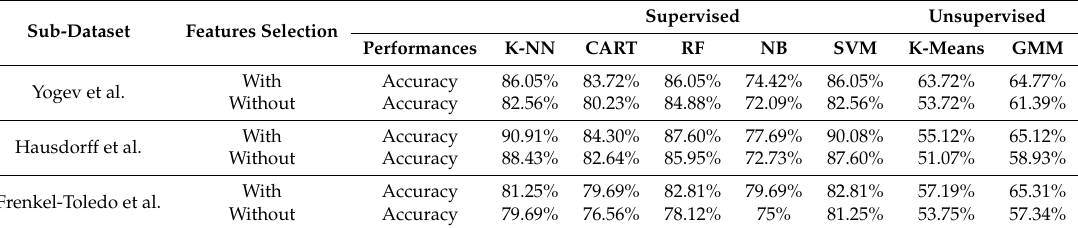
Table 3. Accuracy obtained with/without the use of the feature selection method, for each